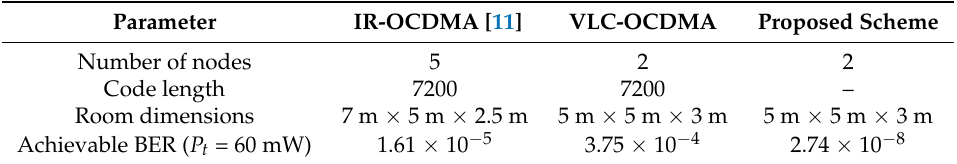
Figure 9. Performance comparison relative to transmit power. Table 2. Comparative analysis of IR-OCDMA, VLC-OCDMA, and the proposed